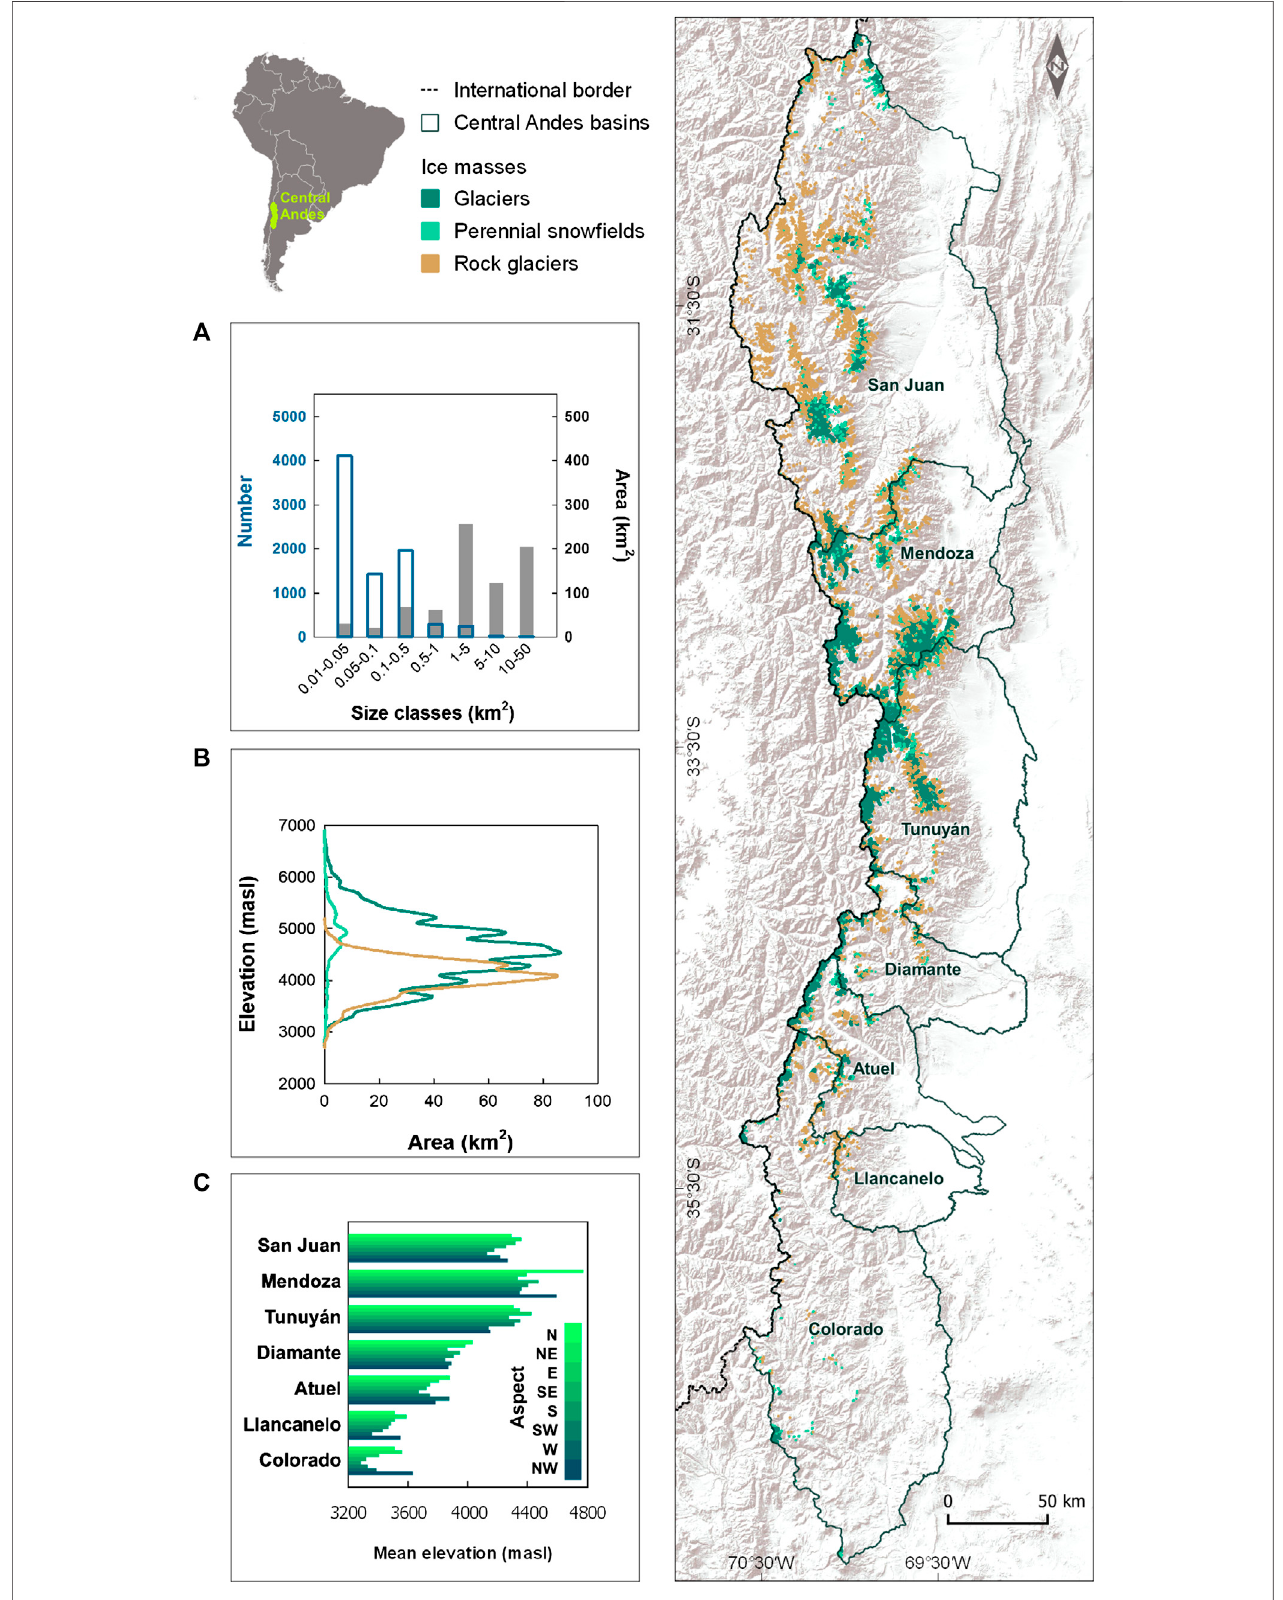
FIGURE3| InventoryoficemassesintheCentralAndesofArgentina. (A) Distributionandnumberoficemassesaccordingtotheirsize. (B) Hypsometryofthedifferenttypes of ice masses. (C) Mean elevation and aspect of the ice masses in the different river basins.